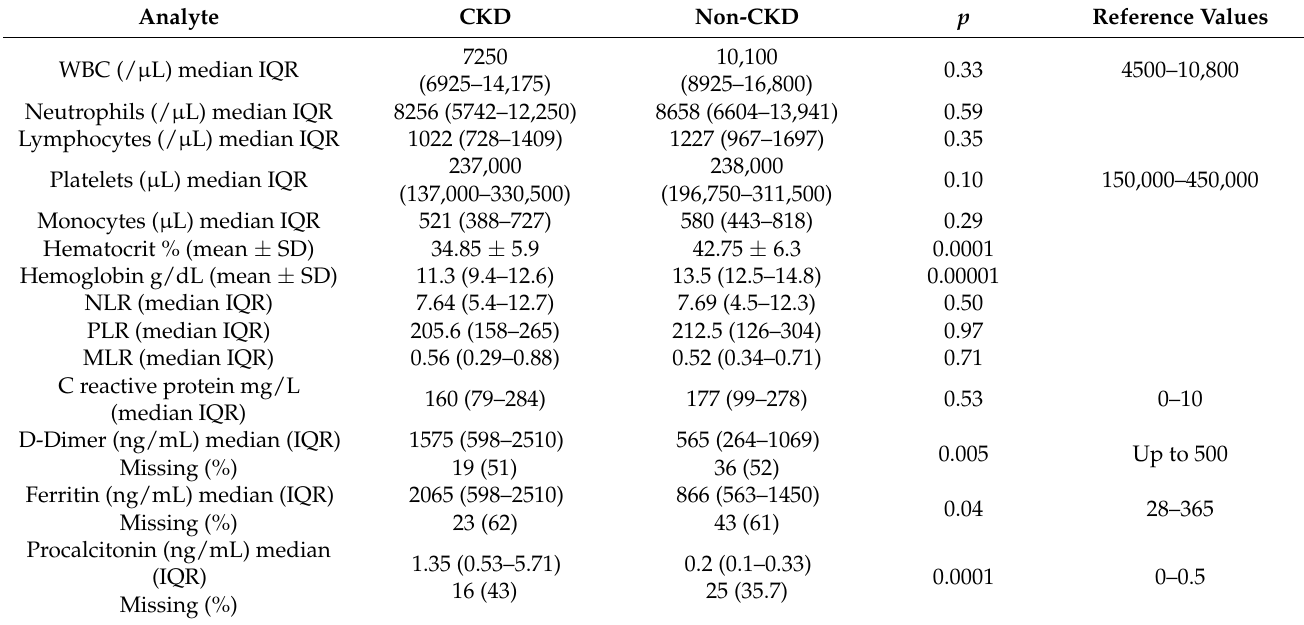
Table 3. Laboratory data.